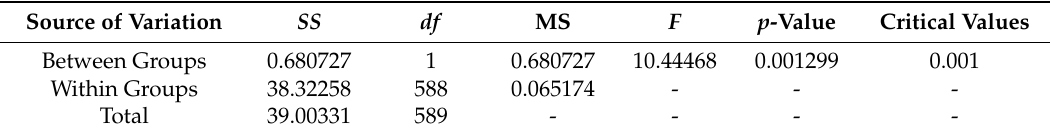
Table 4. Analysis of variance